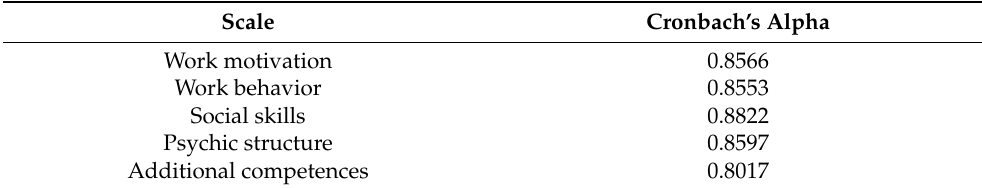
Table 2. Cronbach’s alpha parameters for the different scales of the